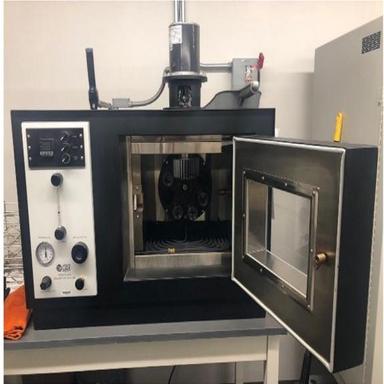
The RTFO apparatus at MAPIL.